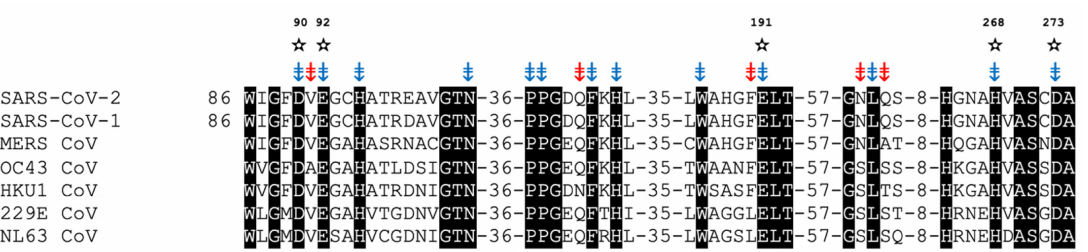
Figure 7. Sequence alignments of ExoNs from the 7 CoVs known to infect humans. ✫ = “DEDDh” motif; Active site residues; ⇟ = Identical, ⇟ = Highly Similar (polarity/size).